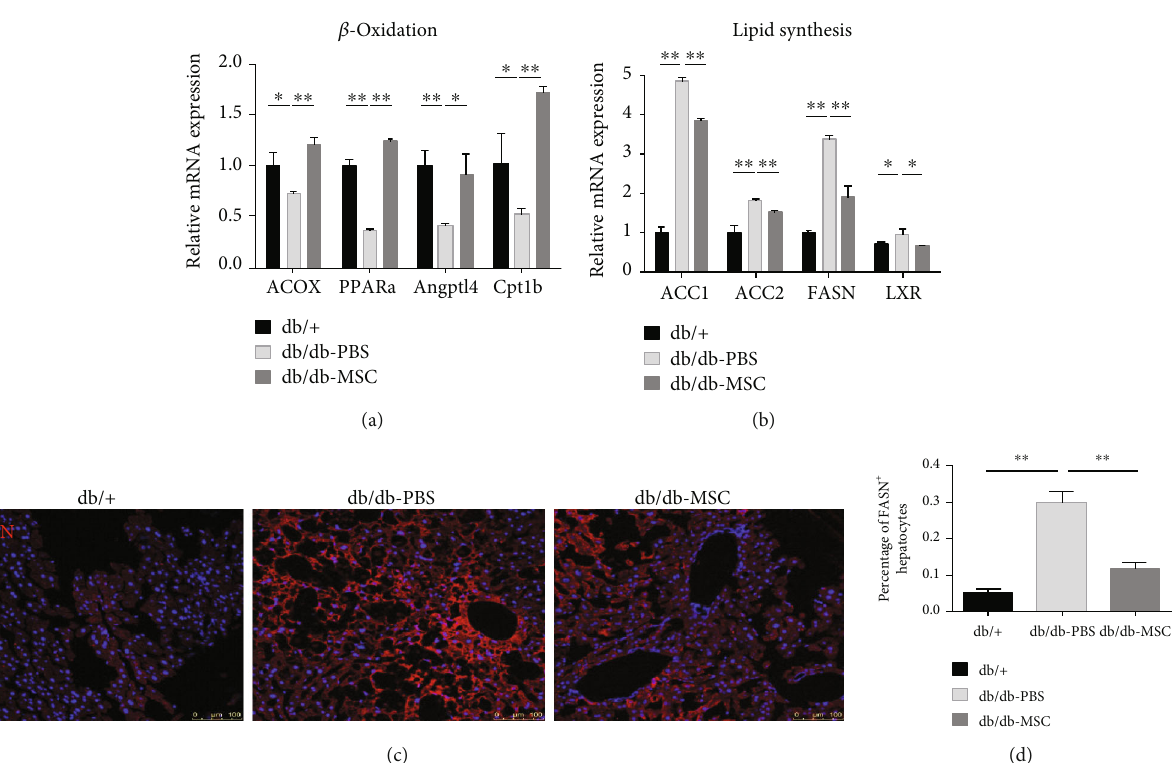
Figure 5: Human UC-MSC infusions promoted β -oxidation and suppressed lipogenesis. Transcript levels of genes related to β -oxidation (a) and lipogenesis (b) in the livers of the indicated groups assessed by qRT-PCR. Each experiment was repeated 3 times. (c) Immuno fl uorescence staining for FASN-positive hepatocytes (bright red fl uorescence) in representative liver sections of the indicated groups ( n = 5 sections per group). (d) The proportion of FASN-positive hepatocytes was quanti fi ed. All the data are expressed as means ± SD . ∗ p < 0 : 05 ; ∗∗ p < 0 : 01